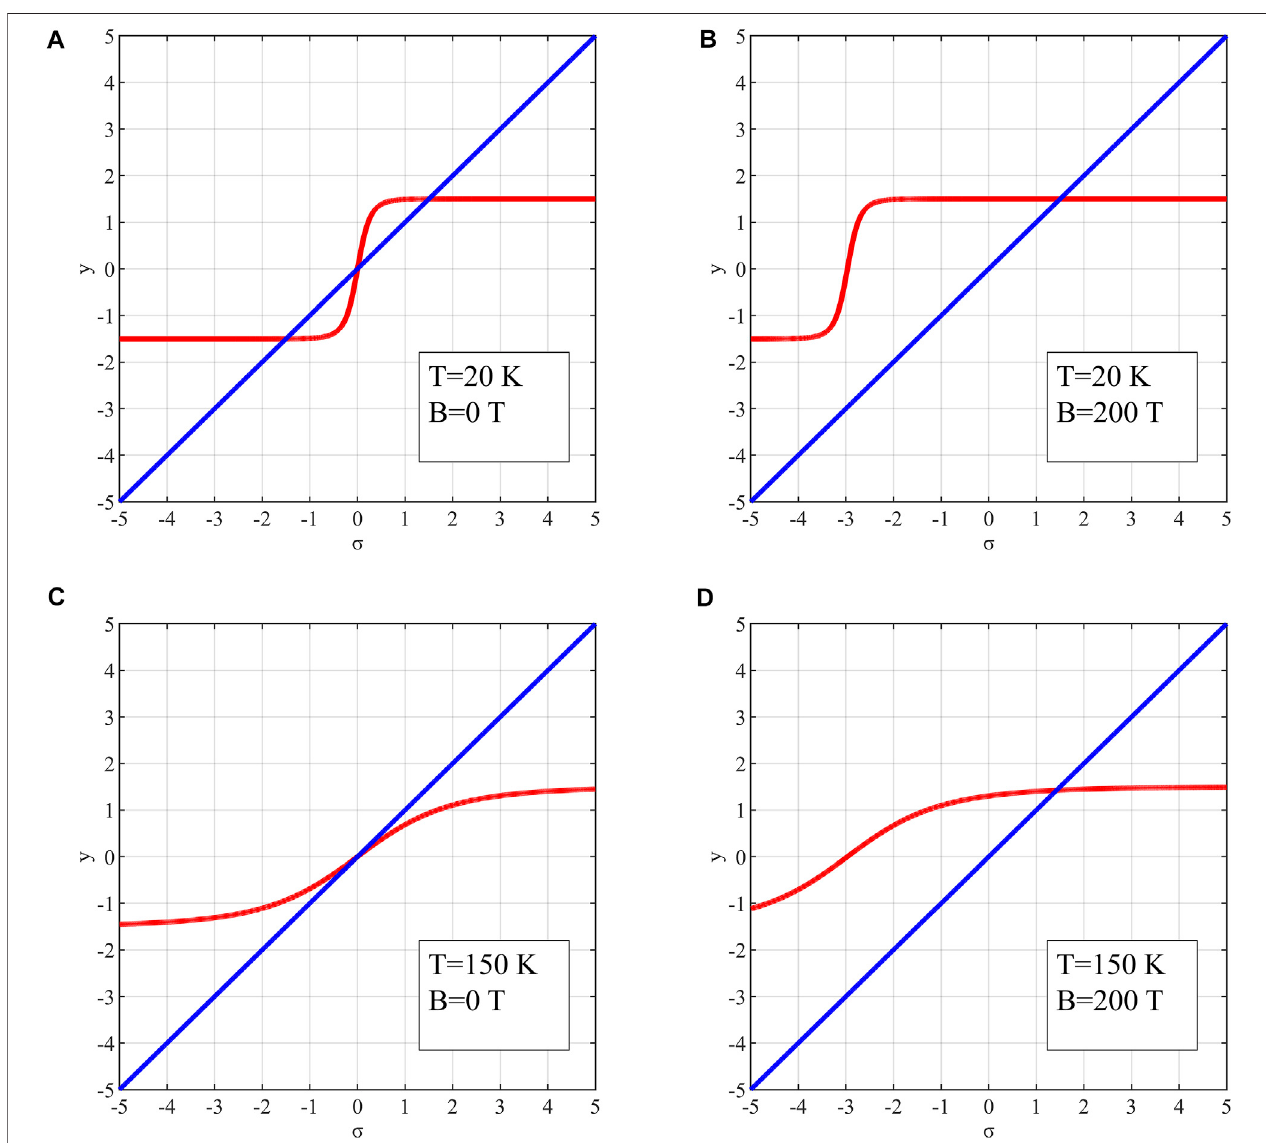
FIGURE 5 | Two functions in Eq. 10 with different parameter sets: (A) T (cid:1) 20 K , B (cid:1) 0 T ; (B) T (cid:1) 20 K , B (cid:1) 200 T ; (C) T (cid:1) 150 K , B (cid:1) 0 T ; (D) T (cid:1) 150 K , B (cid:1) 200 T . The red line represents y (cid:1) SB S ( 2 S J ( 0 )